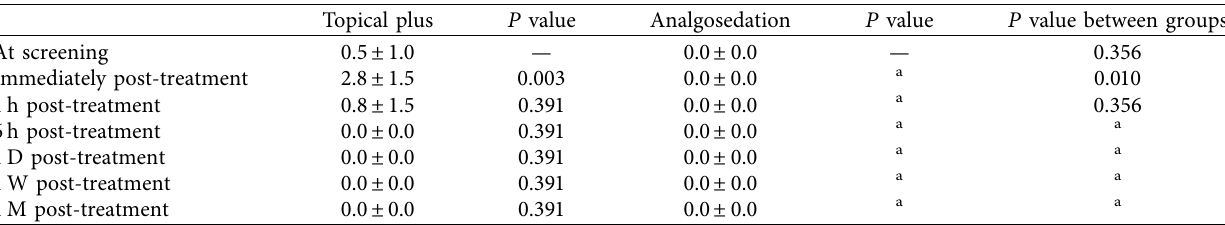
Table 2: Change in reported pain levels.